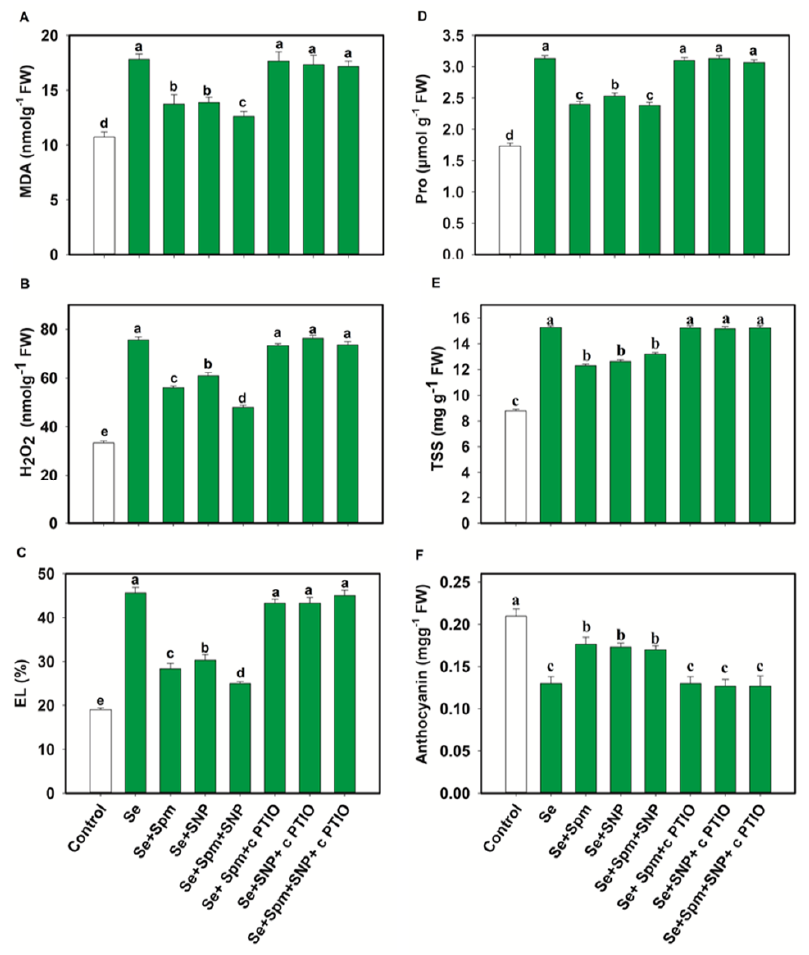
Figure 5. Malondialdehyde content (MDA) ( A ), hydrogen peroxide content (H 2 O 2 ) ( B ). electrolyte leakage (EL) ( C ), Proline (Pro) ( D ), total soluble sugar (TSS) ( E ) and anthocyanin contents ( F ) of leaves of 49-day-old wheat plants grown under control and Se stress (1 mM) sprayed with 1.0 mM Spm or 0.1 mM SNP alone or together, combined with 0.1 mM cPTIO, a NO scavenger. Data presented are the mean (± SE) of three replicates, and bars with dissimilar letters (a–d) represent significantly different results at the p ≤ 0.05 level based on Fisher’s LSD test.